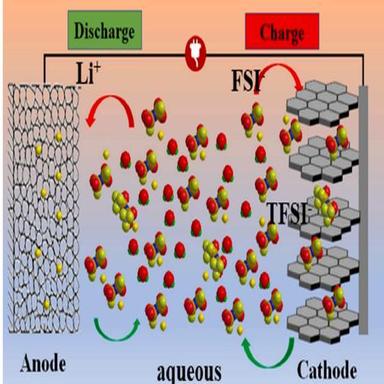
Schematic illustration of the LiFSI–LiTFSI WiBS battery with graphitic carbon cathode and activated carbon anode 0.53 Reproduced with permission from Elsevier.